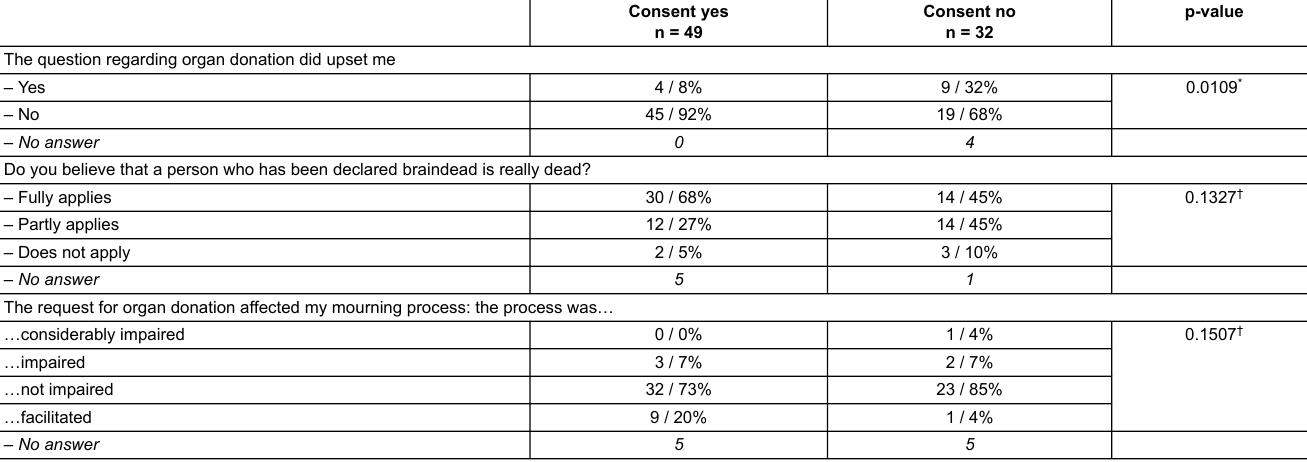
Table 2: Comparison of the groups consenting / refusing organ donation (according to available data, no answer in italics).